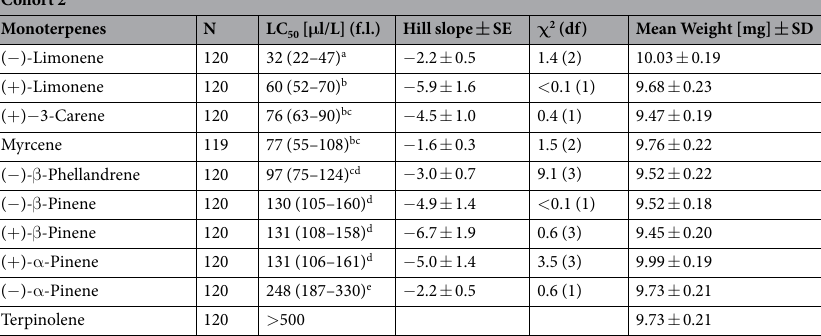
Table 2. Toxicity of monoterpene volatiles against MPB from cohort 2. Dose-response models of the logit- transformed mortality data were used to determine the LC 50 values, 95% fiducial limits (f.l.), and Hill slope for each monoterpene tested. LC 50 values denoted with the same letter were not significantly different. Multiple comparisons between LC 50 values were conducted via pairwise t-tests on the log (LC 50 ) values of the Hill equation, using a pooled standard error, and correcting for experiment-wise error by the Benjamini–Hochberg procedure. The goodness-of-fit test χ 2 (degree of freedom) was used to assess the fit of the dose-response model. Less than 50% of the beetles died at all doses of terpinolene. The mean weight of the beetles tested for each compound in cohort 2 was not significantly different and the mean weight of the beetles tested with a given monoterpene was the same at all doses (ANOVA, p-value = not significant). As sex was not a significant factor in mortality for all monoterpenes tested, the data for both sexes was